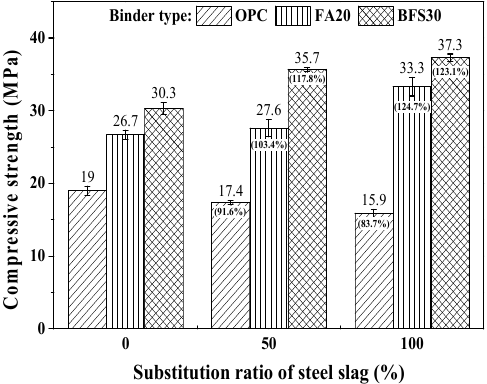
Figure 5. Results of compressive strength test.